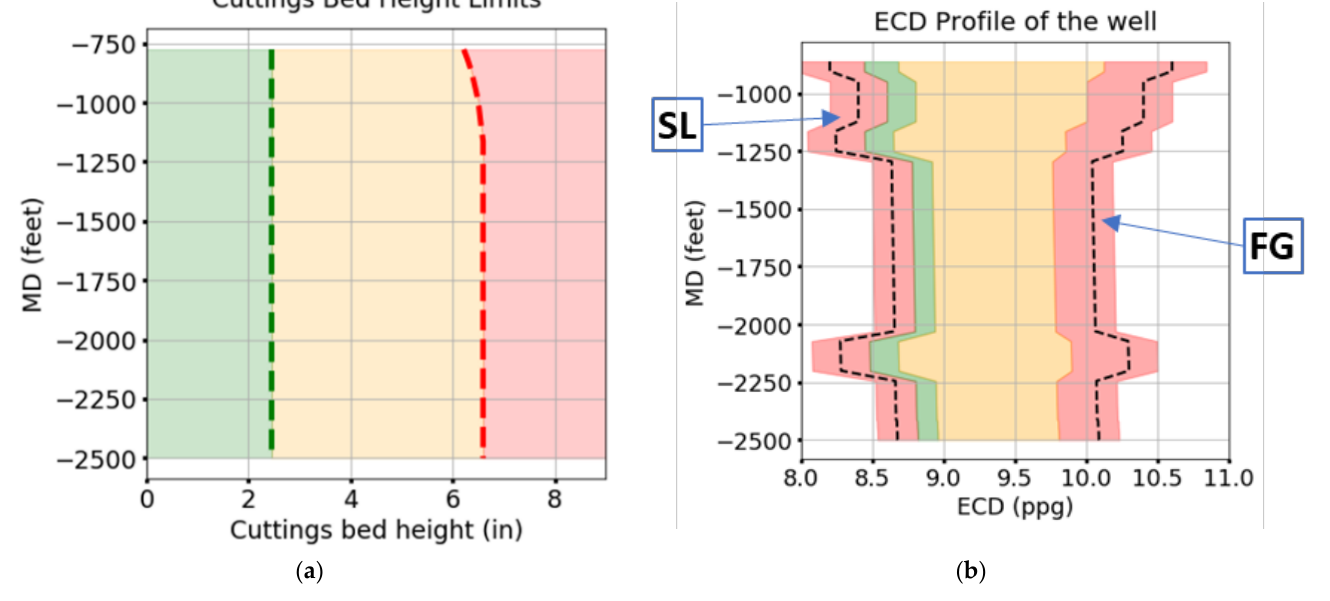
Figure 16. ( a ) Equivalent bed height limits for the given well profile ( b ) ECD limits for the well considering a ten percent uncertainty in the SL and FG values (negative sign indicates downward depth into the sub-surface).